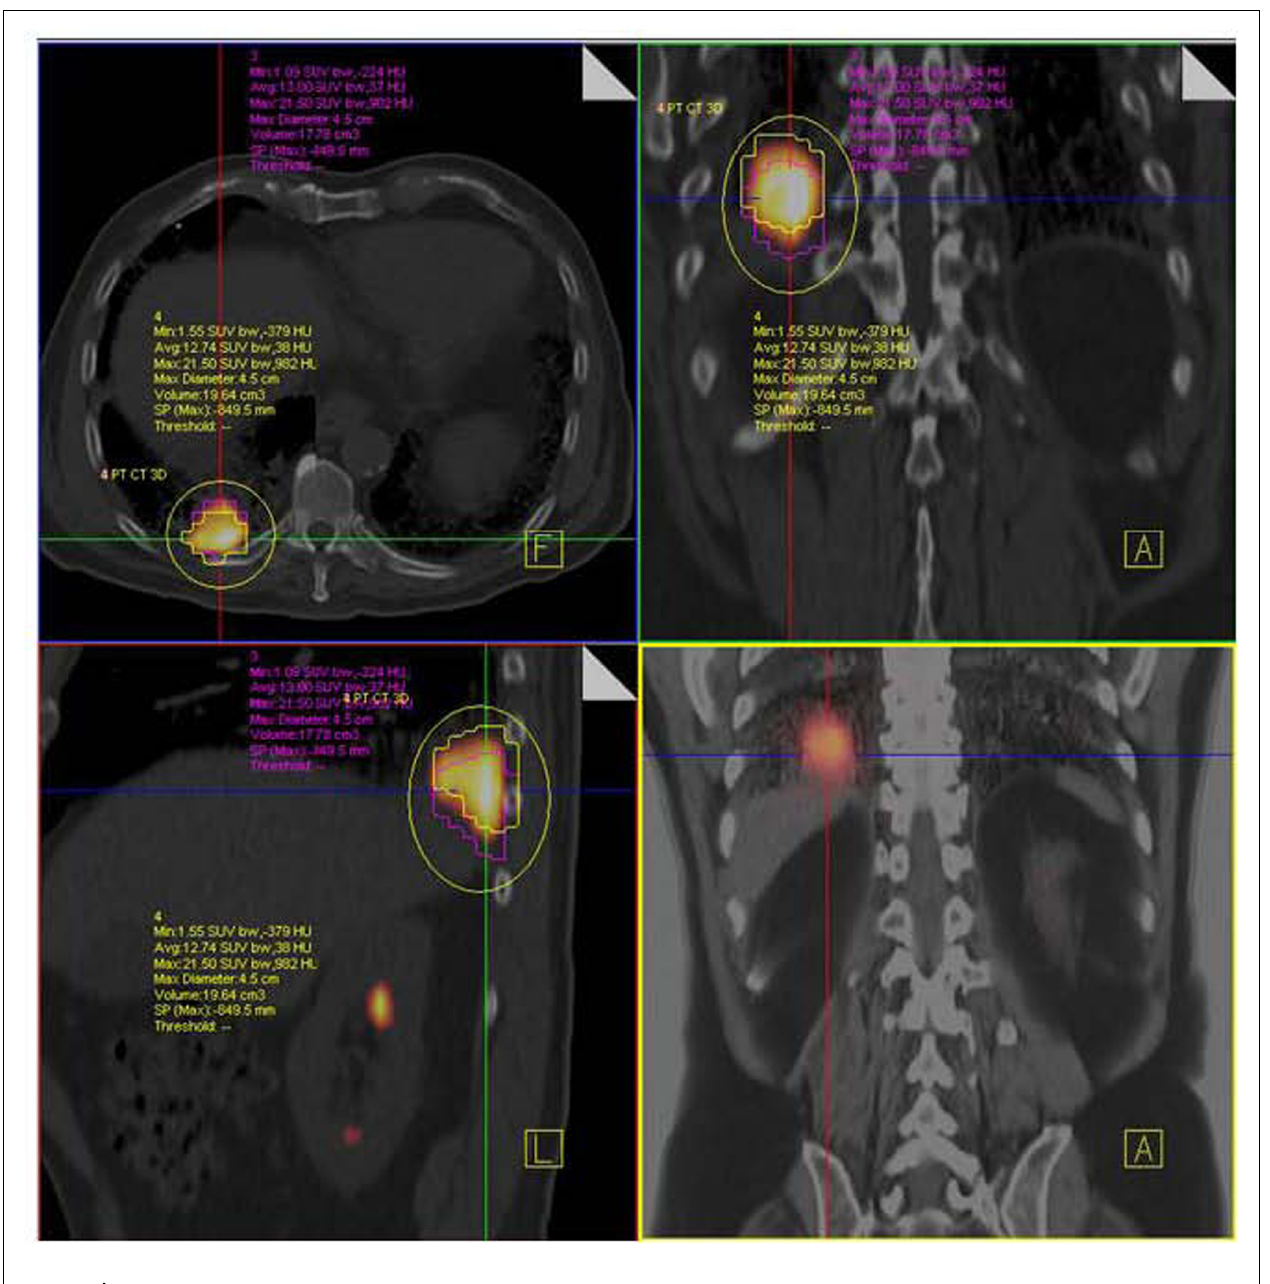
FIGURE 9 | NSCLC at right lung base. F18 FDG PET/CT shows hypermetabolic tumor mass close to diaphragm and posterior thoracic wall without nodal or distant metastases. Respiratory-gated PET/CT was